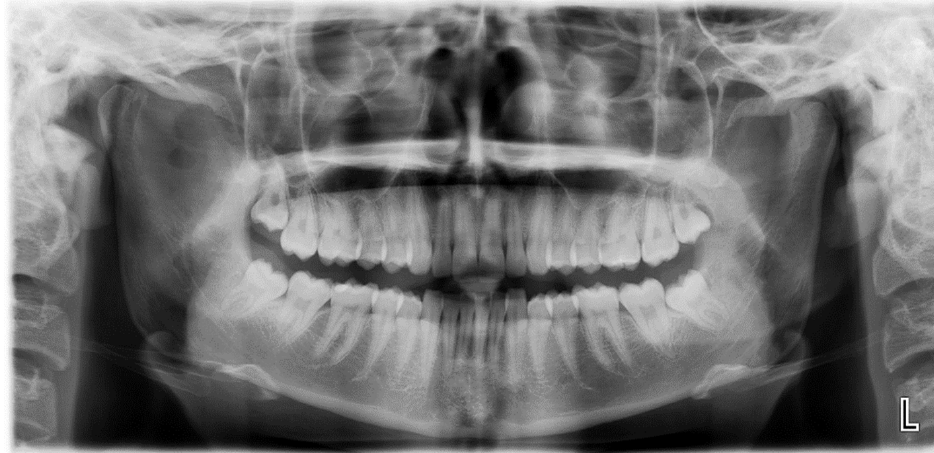
Figure 1. Patient’s OPG showing no evident anomalies.